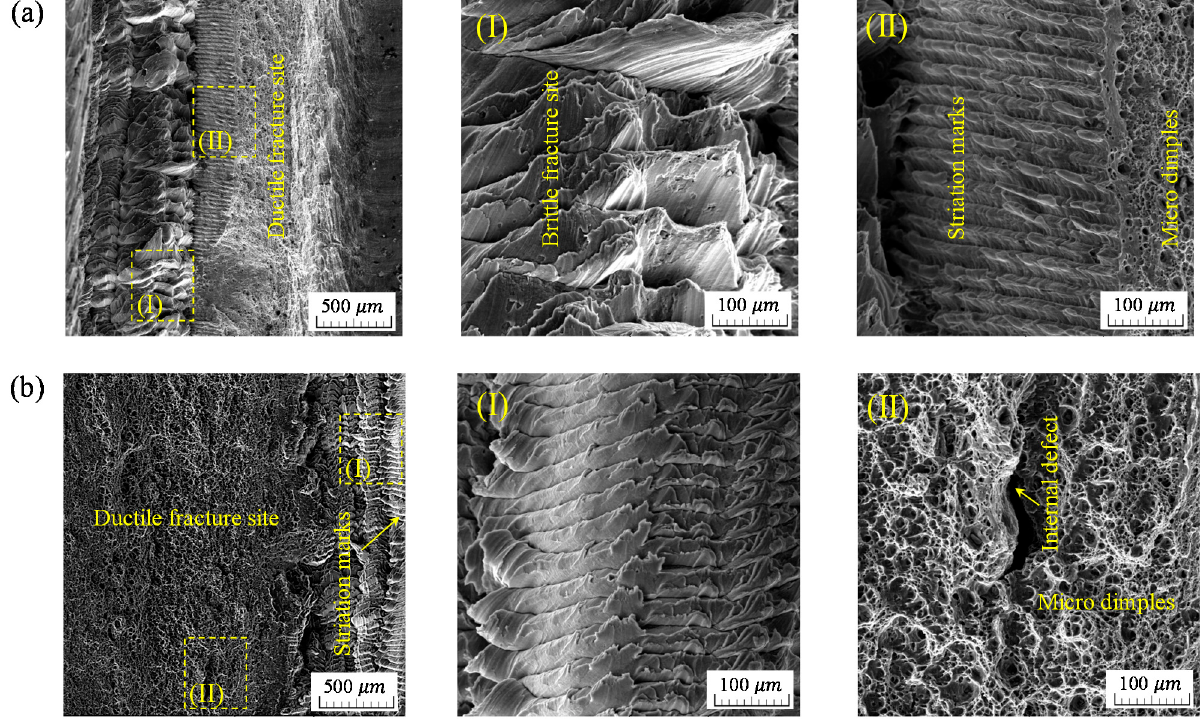
Figure 17. SEM images of fracture surface: ( a ) as-welded FSW joint sample; ( b ) STA heat-treated FSW joint sample.